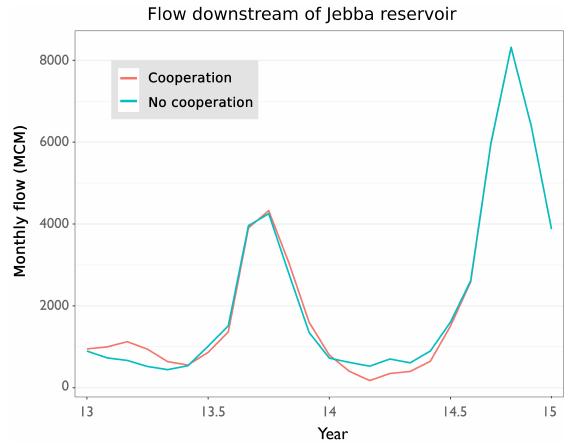
Figure 8. Comparison of monthly streamflow immediately down- stream of Jebba reservoir between model runs when an agent de- cides to cooperate and when it does not